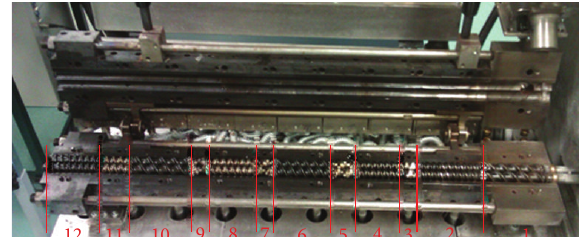
Figure 1: View of the opened plastisizing unit with screws working in a corotating mode. Zone 1: feed area (32 mm screw stroke), zones 2, 4, 6, 8, and 11: transporting sections, zones 3, 5, 7, and 9: kneading and mixing elements, zone 10: degassing unit, and zone 12: metering section (16mm screw stroke). Compression factor =